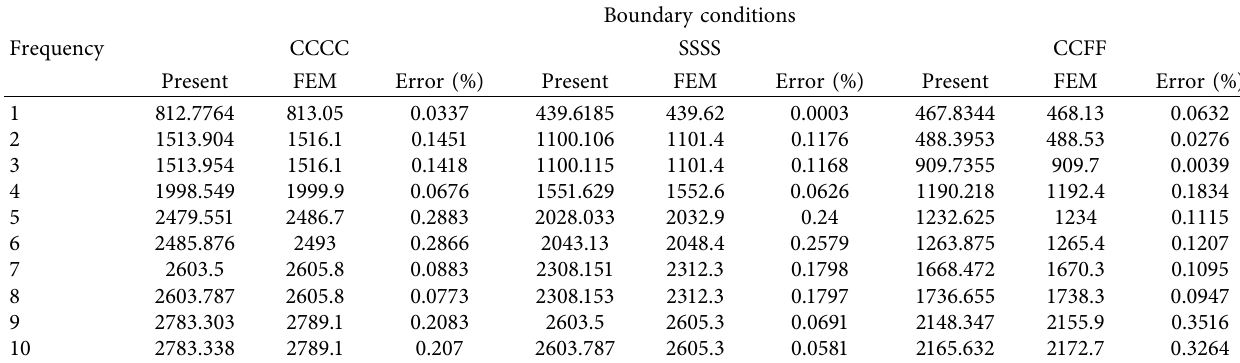
Table 4: Comparison of natural frequency of non-stepped isotropic